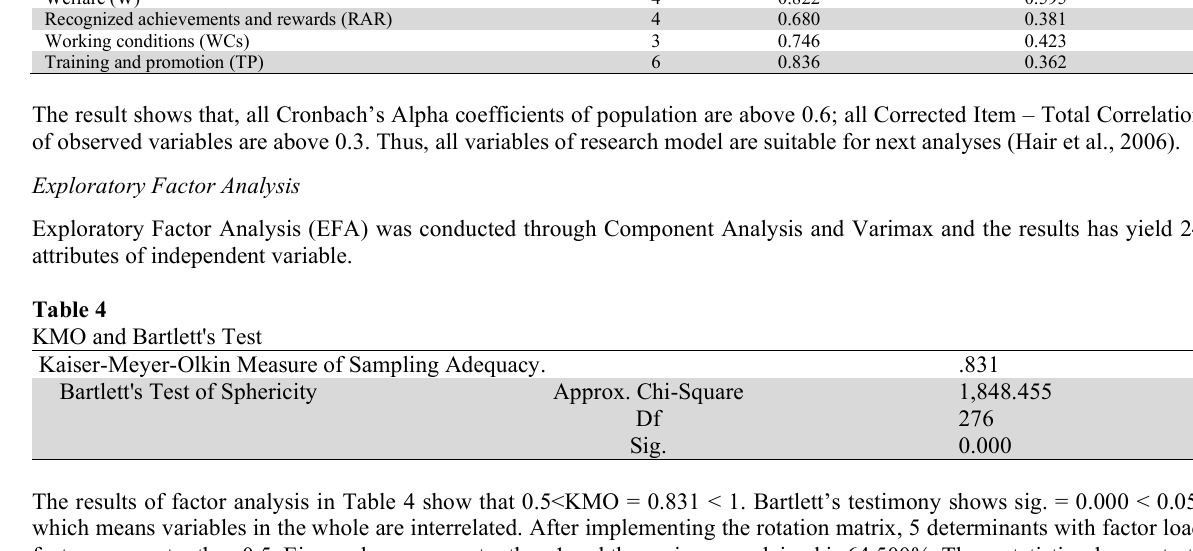
Quality scale analysis result